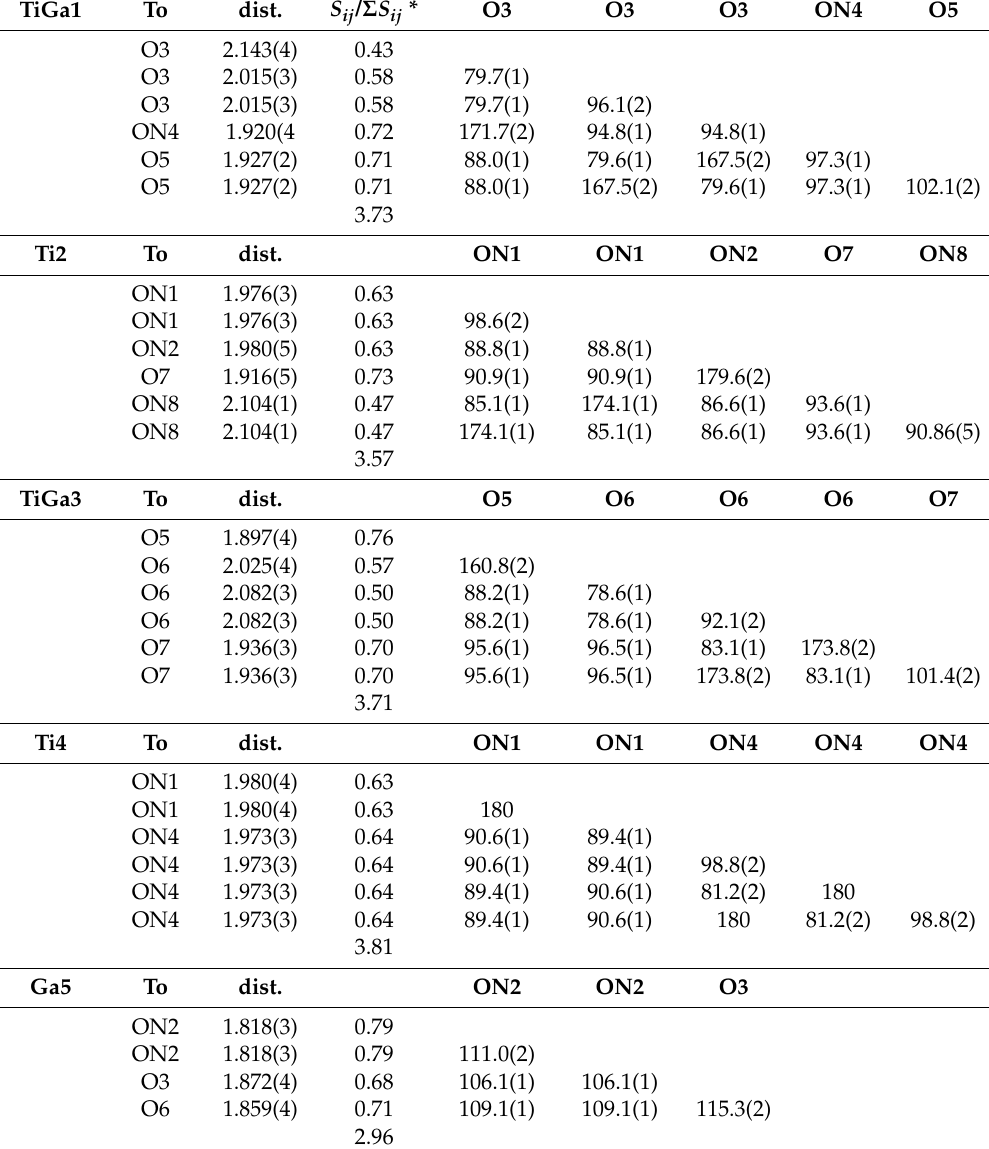
Table A2. Selected interatomic distances (Å) and angles ( ◦ ) for the Ga-Ti-O-N